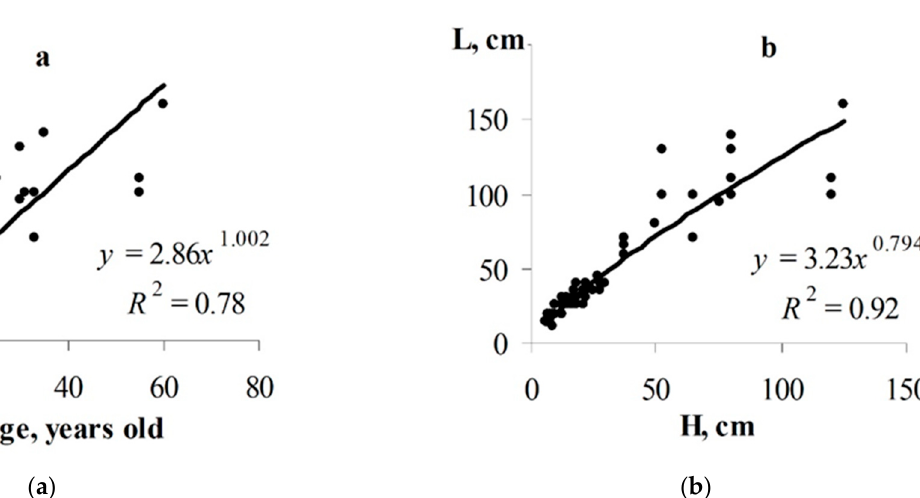
Figure 7. Relationship between the root length of the Pinus sibirica undergrowth and its age ( a ) and height ( b ).